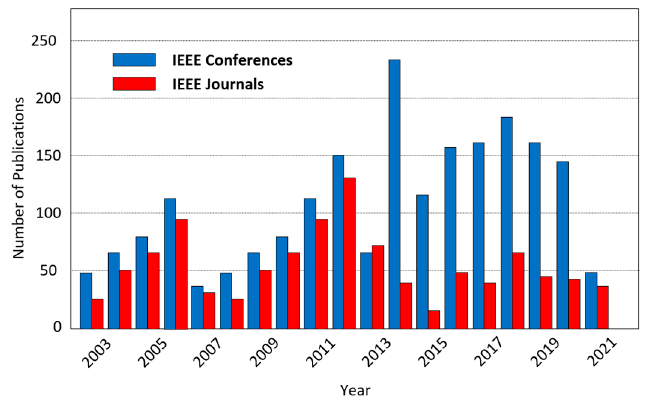
Figure 5. The number of published papers per year on ZSIs from 2003 to 2021. Among Z-source-based inverter topologies, the Quasi-Z Source Inverter (QZSI), shown in Figure 6, offers some advantages, such as continuous supply current [40].